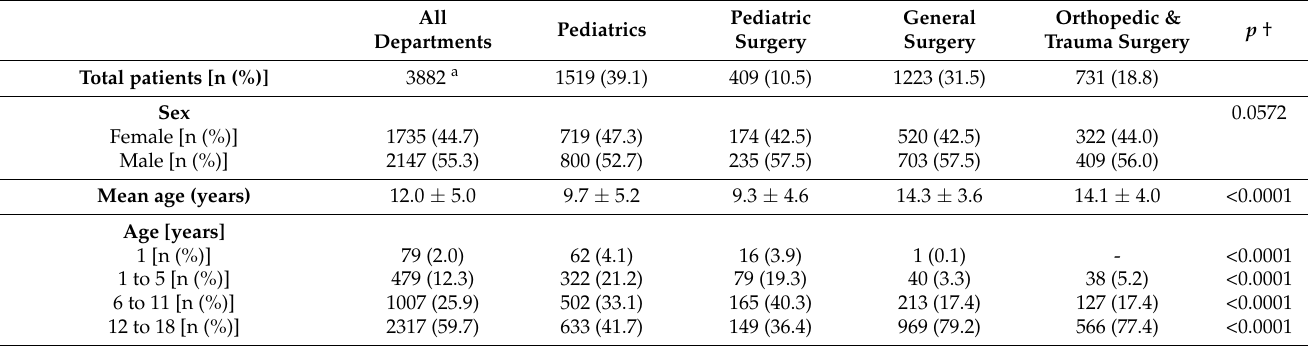
Table 3. Patient characteristics in different